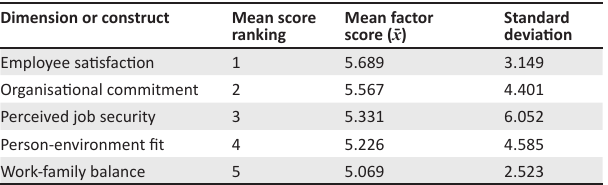
TABLE 3: Mean score rankings of the work-related factors, employee satisfaction and organisational commitment. Dimension or